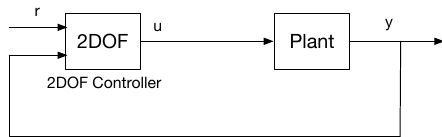
Figure 8. Schematic diagram of 2DOF